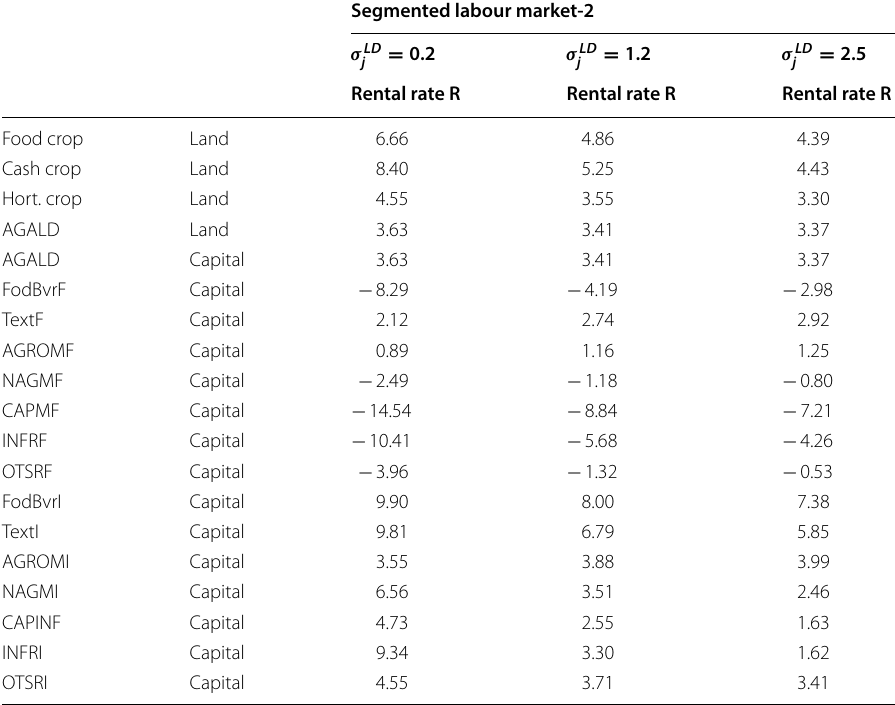
Table 21 (Scenario A3:S1–S3) Change (%) in sectoral rental rate due to 50% tariff cut